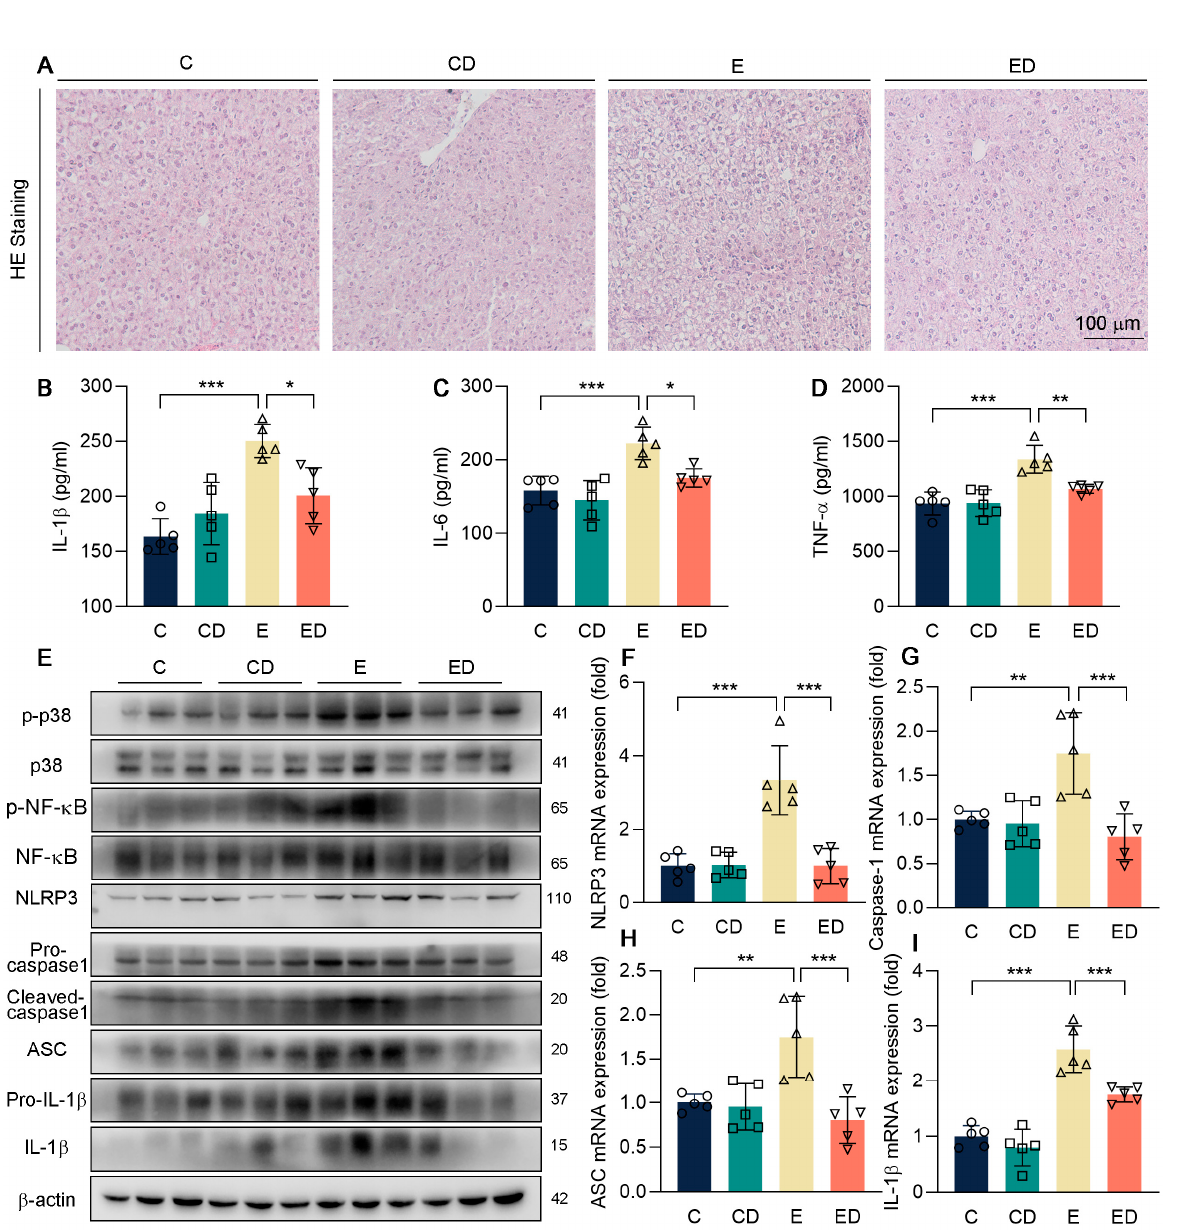
Figure 3. The effect of DAU on hepatic inflammation induced by alcohol. ( A ) Hepatic H&E staining of mice. ( B – D ) Serum IL − 1 β , IL − 6, TNF − α levels. ( E ) Protein expression of p − p38, p38, p − NF − κ B, NF − κ B, NLRP3, pro − caspase1, cleaved − caspase1, ASC, pro − IL − 1 β and IL − 1 β in mice